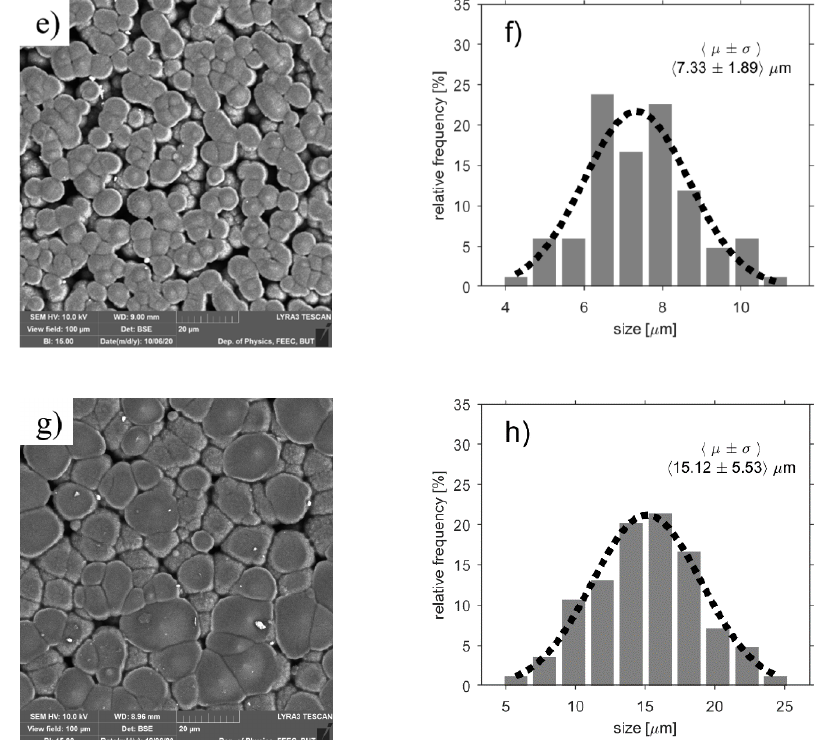
Figure 1. Scanning electron microscope (SEM) images and particle size distribution histograms of the studied SPEs after different preparation conditions: ( a , b ) 80 °C for 90 s ( c , d ) 120 °C for 90 s ( e , f ) 120 °C for 210 s ( g , h ) 160 °C for 600 s.